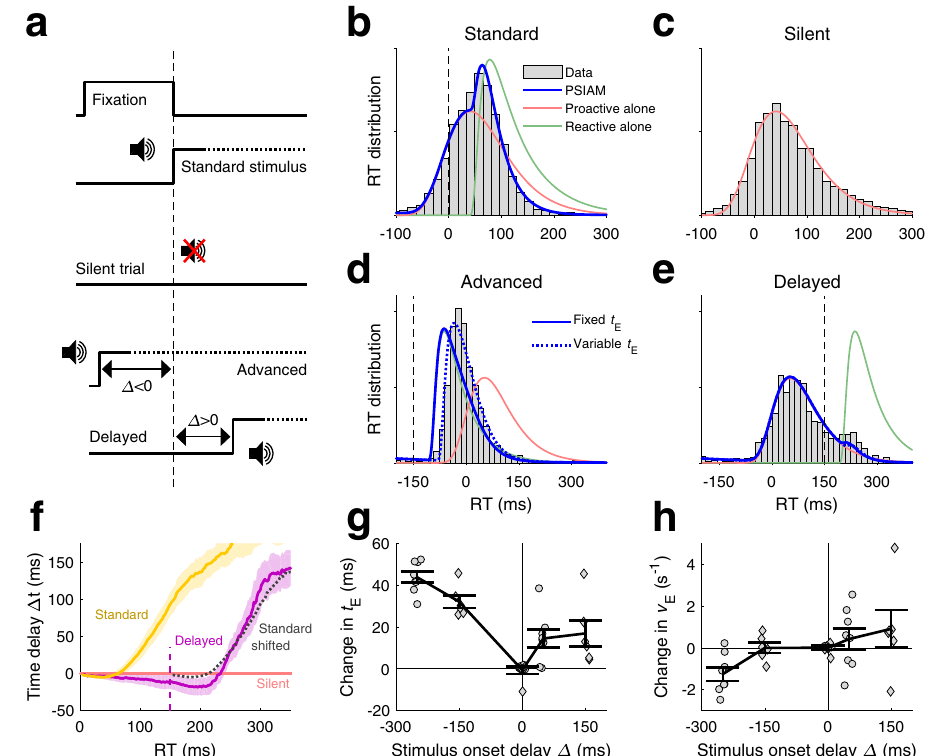
Fig. 5 Reaction times in experiments with perturbed stimulus onset. a In silent sessions, the stimulus was absent in 10% of trials (silent trial; Group 2, n = 6). In advanced/delayed stimulus sessions, the stimulus was advanced in 5% of trials ( Δ = − 150 ms for Group 2 and − 250 ms for Group 3, n = 8) and delayed in other 5% of trials ( Δ = + 150 ms in Group 2 and + 50 ms in Group 3) with respect to the standard onset time. b RT distribution for an example rat (gray bars; rat #43) and model fi t (PSIAM, blue line) for maximum stimulus strength ( s = 1) in standard trials in silent sessions. Red/green lines: RT distributions generated by the AI/EA processes in isolation. Vertical dashed line: stimulus onset. c RT distribution in silent trials from the same rat (gray bars). Model prediction corresponds to the RT distribution of proactive alone responses obtained from standard trials (red line; same as in b ). d Same as in panel b but for a different example rat in advanced trials ( Δ = − 150 ms; rat #44). Model prediction corresponds to advancing the reactive alone